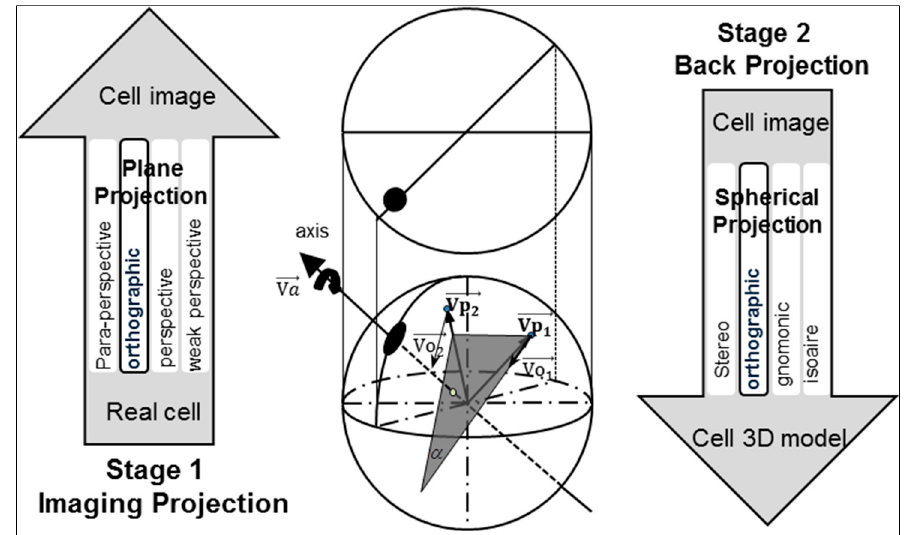
Figure 5. The image mapping process for the 2D and 3D models. In stage 1, the real cell projects its image onto the 2D plane, while in stage 2, the 2D image is back projected to a 3D model. V represent two vectors from the center of the sphere to the points on the sphere surface. 2 p V their 3D optical flow vectors when the sphere rotates around the axis and 2 o